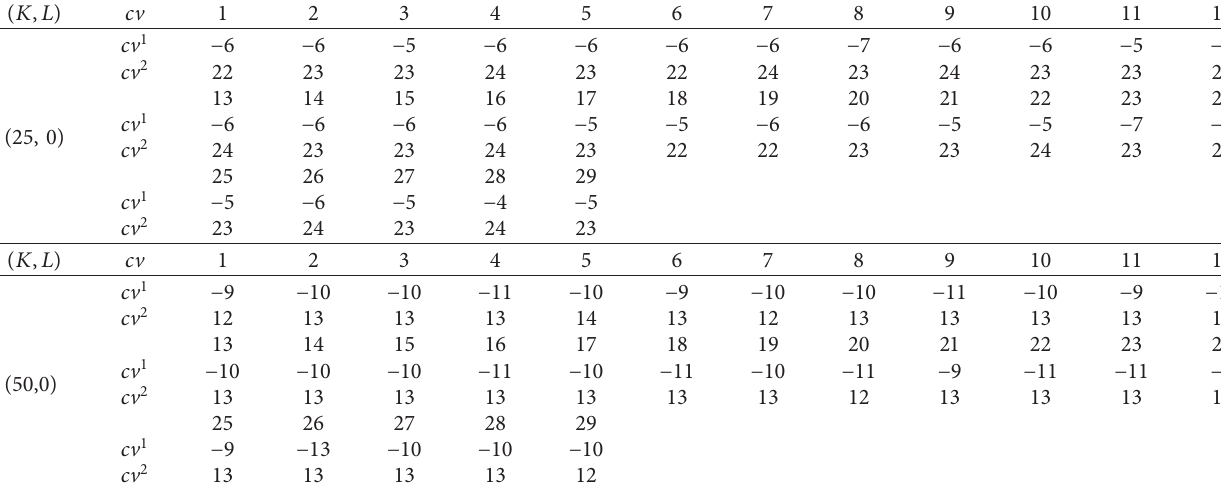
Figure 11: Log-log scale MEP difference for lifetime 4. Table 14: Critical values for L � 0.